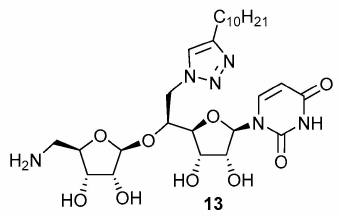
Figure 3. Structure of the reference N -triazole inhibitor 13